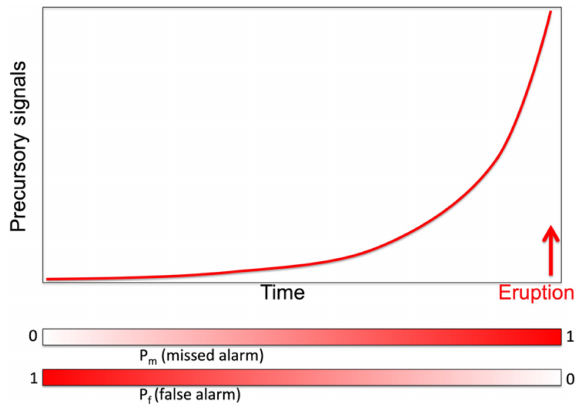
Figure 1. Sketch of an “ideal’ evolution in time of precursory sig- nals before an eruption. When declaring an eruption alert shortly after the beginning of precursory signal increase, the probability of a false alarm is very high, but the probability of a missed alarm is low; in contrast, when declaring an alert only when precursory sig- nals are extremely high, the probability of a false alarm is low, but the probability of a missed alarm (in the sense of “too late”) is very high because the eruption could start suddenly, before any civil pro- tection measure (normally, evacuation of the most risky areas) can be completed.